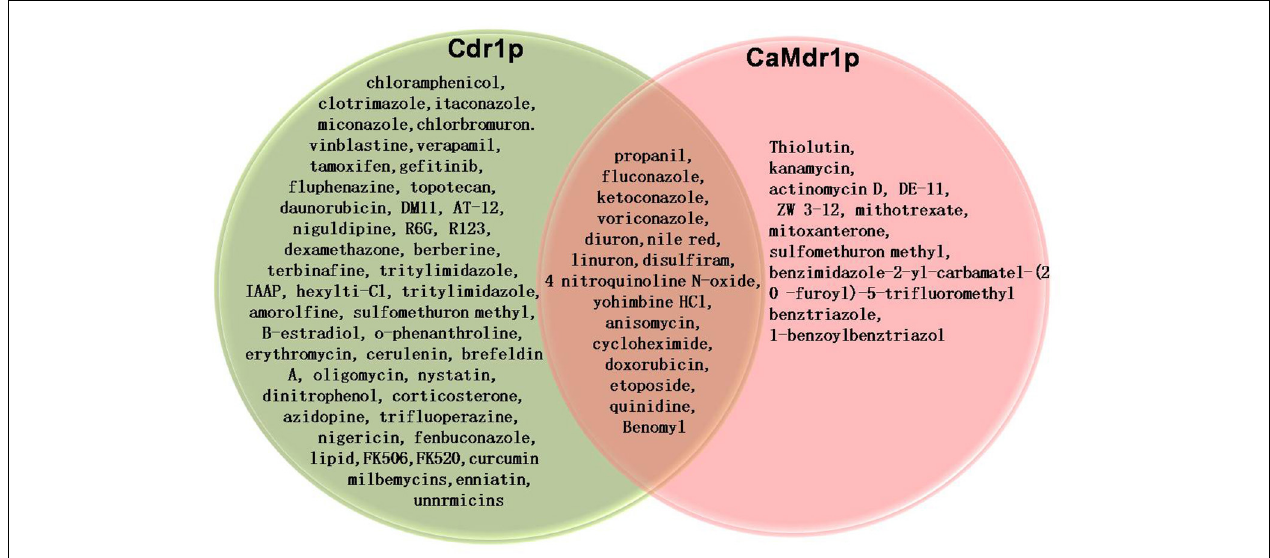
FIGURE 1 | Venn diagram showing substrates which are common and distinct for Cdr1p and